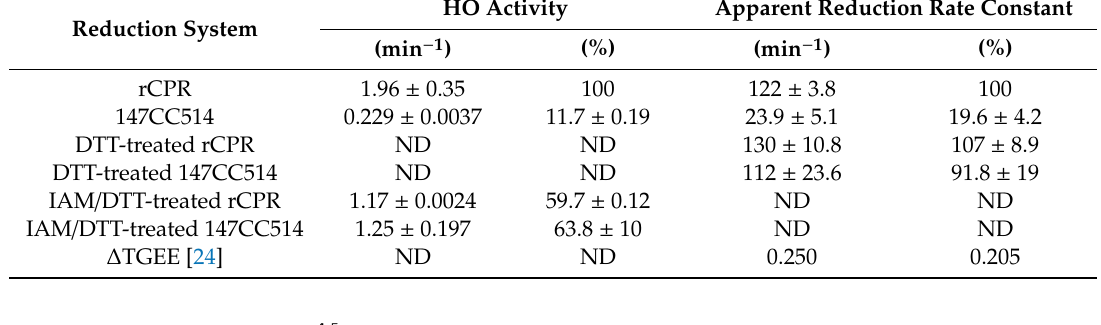
Table 1. Summary of the enzymatic assays. HO, heme oxygenase; rCPR, rat cytochrome P450 reductase; DTT, dithiothreitol; IAM, 2-iodoaceteamide.